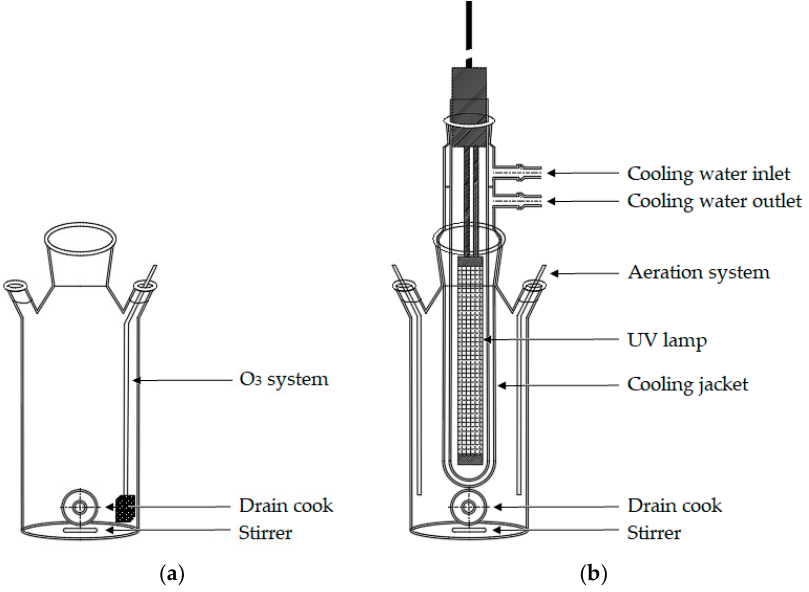
Figure 1. Reactor for the ( a ) H 2 O 2 , O 3 and ( b ) UV, UV/TiO 2 [10]